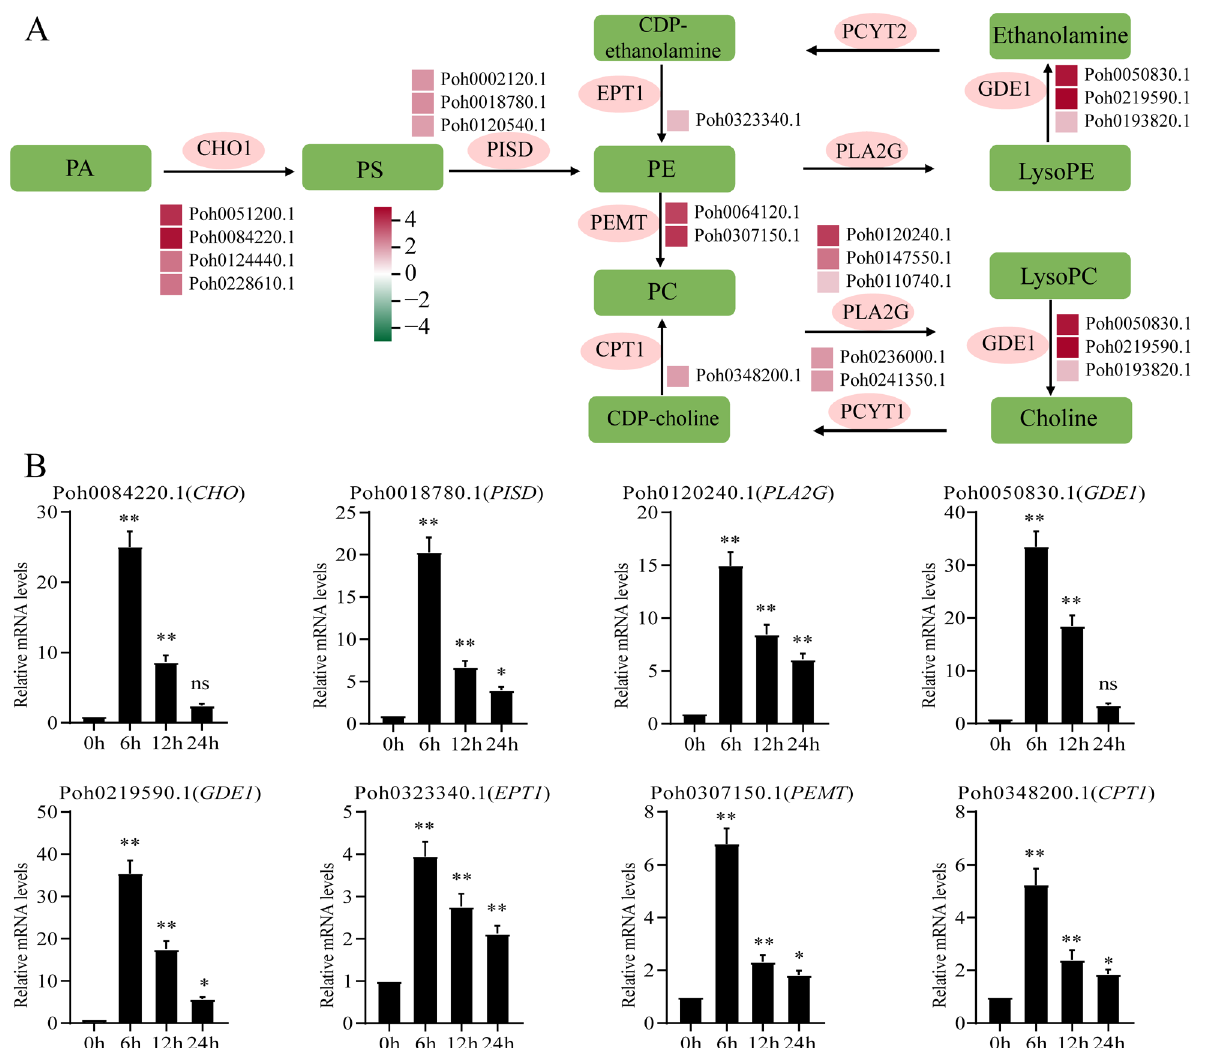
Figure 6. Glycerophospholipid metabolism pathway and differentially expressed genes. ( A ) The basic phospholipid biosynthetic pathway with heatmap showing gene expression levels. The left block of each gene indicated the log 2 (fold change) under OPDA treatment obtained from transcriptome se- quencing analysis. ( B ) qPCR analysis confirmed that several genes involved in phospholipid biosyn- thesis were markedly upregulated under OPDA treatment. CHO1 , CDP-diacylglycerol-serine O -phos- phatidyltransferase; PISD , phosphatidylserine decarboxylase; PLA2G , secretory phospholipase A2; PEMT , phosphatidylethanolamine/phosphatidyl-N-methylethanolamine N -methyltransferase; GDE1 , glycerophosphodiester phosphodiesterase; PCYT1 , choline-phosphate cytidylyltransferase; CPT1 , di- acylglycerol cholinephosphotransferase. Significant difference (* p < 0.05, ** p < 0.01, ns, no significant).